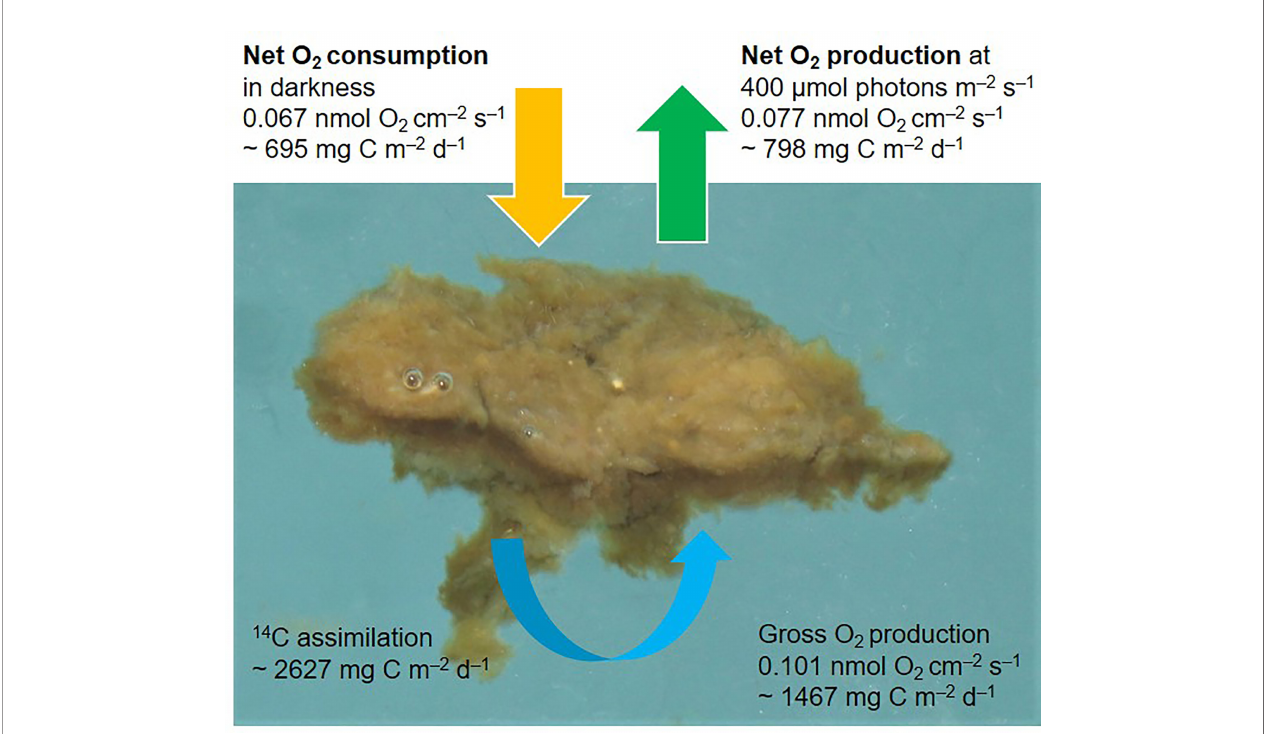
FIGURE 3 | Rates of dark oxygen respiration (yellow arrow), net community production (green arrow), and gross oxygen production (blue arrow) in a melt pond algal mat, derived from oxygen concentration pro fi les and 14 C-assimilations. Units per surface area of the mat in nmol O 2 cm – 2 s – 1 and the equivalent in mg C m – 2 d – 1 , assuming a O 2 :C ratio of 1.0 for net rates and 1.4 for gross production, under 24h sunlight (midnight sun). Note the small bubbles of oxygen on the mat surface to the left, which originate from O 2 supersaturation and indicate a high net community O 2 production within the mat. Photo by K. Hancke.